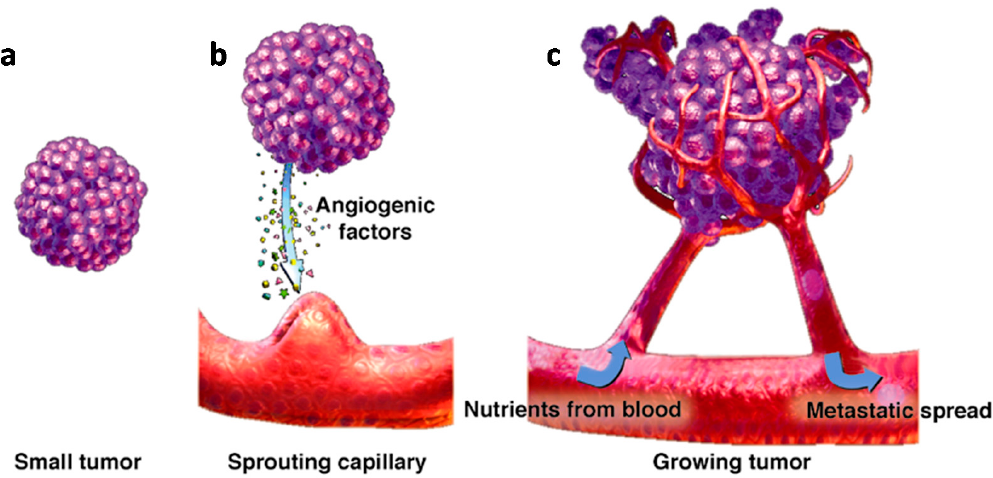
Figure 2. ( a–c ) Tumor expansion induced by the sprouting of blood vessels. From small tumor ( a ), sprouting capillary ( b ) to growing tumor ( c ). Adapted from Garrel, D.; Augstburger, R.; Townsend Lett. Dr. Patients 2004 , 246 , 74–79. Copyright 2004 Townsend Letter.